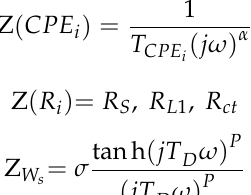
Table 8. EIS Parameters obtained by substrate experimental data fitting (Model 1, Figure 19).